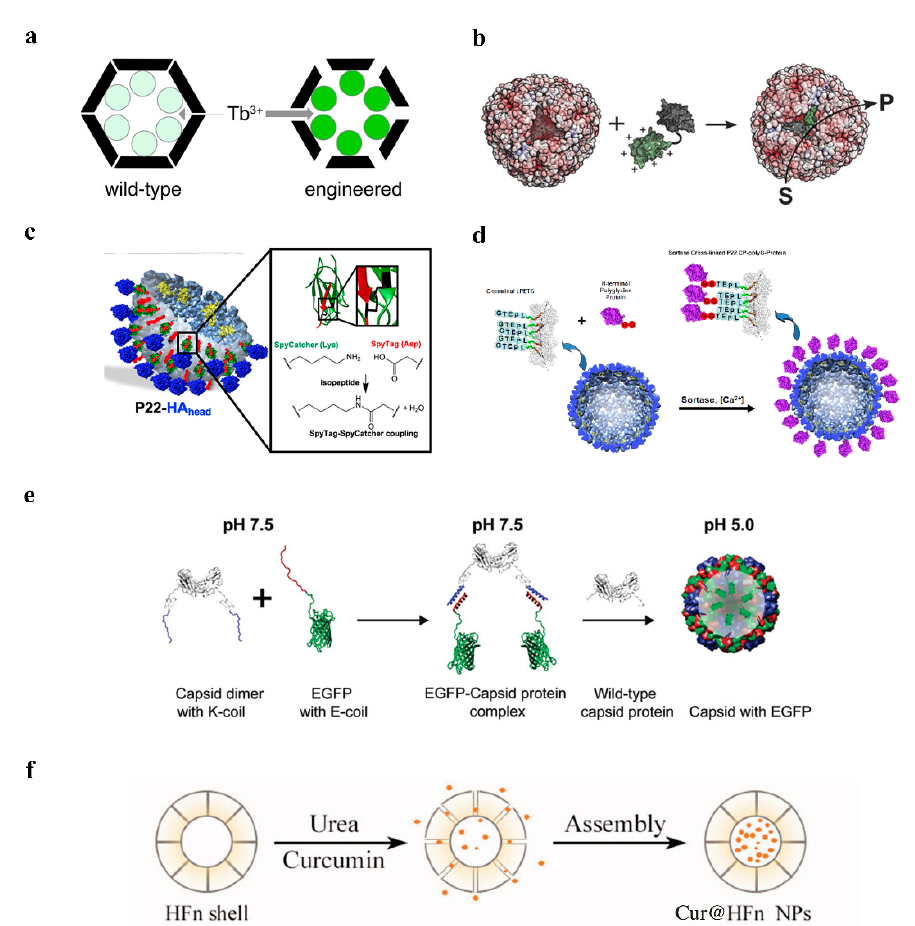
Figure 2. The strategy of encapsulating drugs with protein cage NPs. ( a ) TB 3+ diffuses into encapsulin. Reprinted with permission from Ref. [19]. Copyright 2018, American Chemical Society. ( b ) Positively charged green fluorescent protein GFP (+36) could be encapsulated into AfFtn. Reprinted with permission from Ref. [21]. Copyright 2021, Wiley-VCH Verlag GmbH & Co. KGaA,